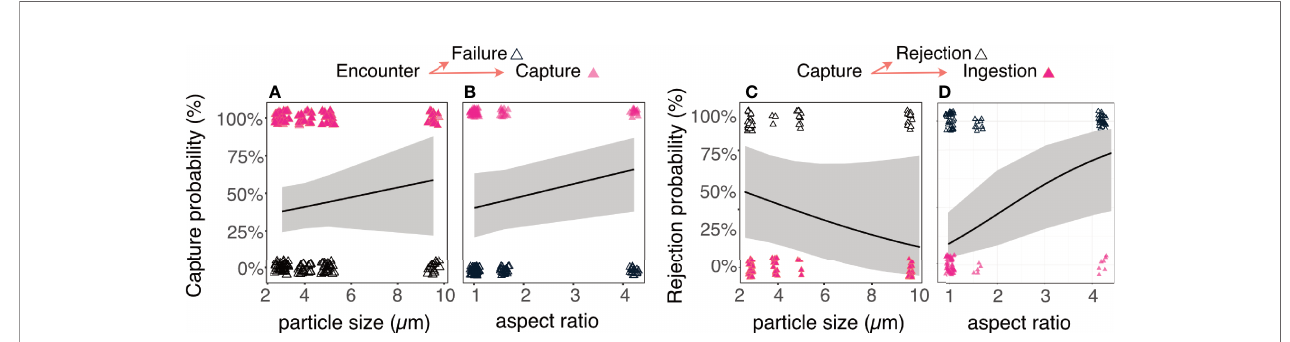
FIGURE 7 | Prey selectivity is the outcome of selective capture and handling. Upon encounter (A, B) , capture probability signi fi cantly increased with particle size, however the relationship between capture success and aspect ratio was non-signi fi cant ( SEM Table 6 ). After prey capture (C, D) , rejection probability signi fi cantly decreased with particle size, and signi fi cantly increased with the particle ’ s aspect ratio ( SEM Table 6 ). The size distribution and dimensions of the ingested prey ( Figure 5 ) are therefore the result of integrating the processes occurring at the stages of capture and handling. Open triangles denote a negative outcome (particles not captured/rejected), while closed (pink) triangles denote a positive outcome (particles captured/not rejected). Lines and shaded areas are the logit function depicting the probability of capture of rejection (± CI) for a given particle size/aspect ratio from a GLM model.